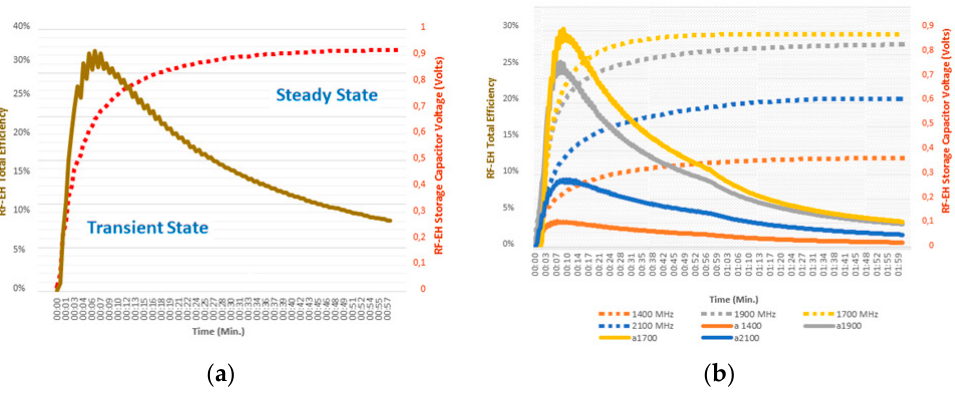
Figure 7. ( a ) The RF-EH’s total efficiency response ( a) at 1700 MHz and ( b ) the RF-EH’s total efficiency in several operating frequencies, tested at the laboratory. The RF-EH’s storage capacitor charging response is showen by the dashed lines, respectively.